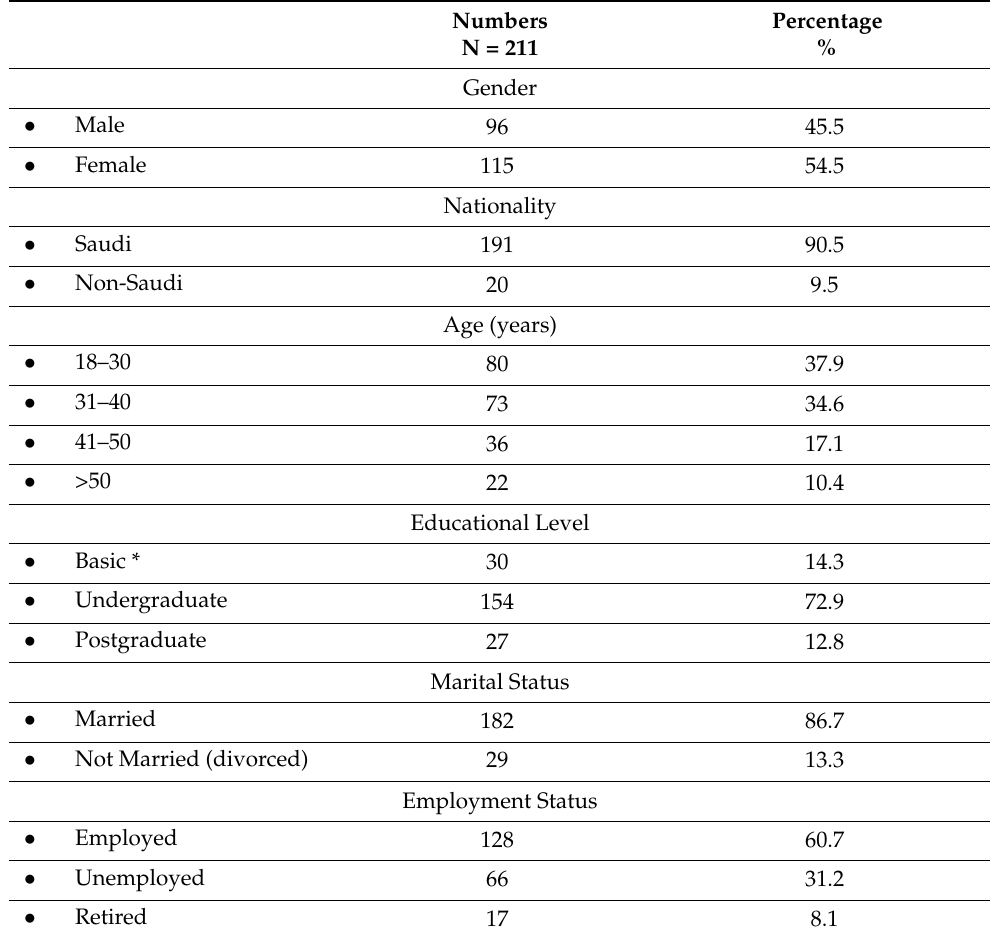
Table 1. Sociodemographic characteristics of the